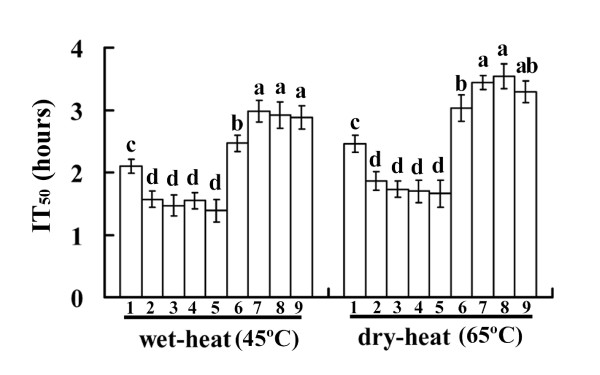
IT50 of M. acridum wild-type strain and Ntl mutants. IT50: inhibition time values for 50% germination of aqueous conidial suspensions exposed to 45°C and dried conidia exposed to 65°C, respectively. 1: wild-type strain; 2-5: over-expression mutants; 6-9: RNAi mutants. Standard error (SE) bars show averages for three independent experiments. Significant differences are designated by the different lowercase letters on the bars of each group in the wet-heat or dried-heat test (p < 0.05).